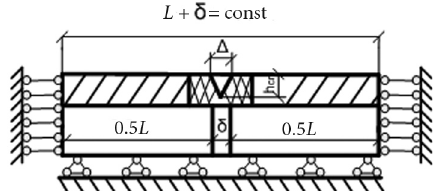
Fig. 8. Design model for the calculation of stresses in asphalt concrete pavement after repairing activities after sealing cracks in asphalt concrete layer on a cracked basis